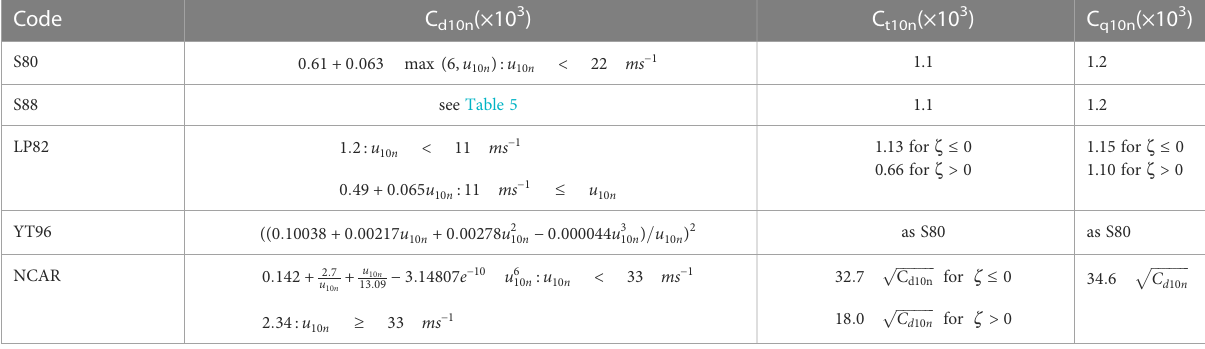
TABLE 4 Parameterizations de fi ned in terms of the 10 m neutral exchange coef fi cients.